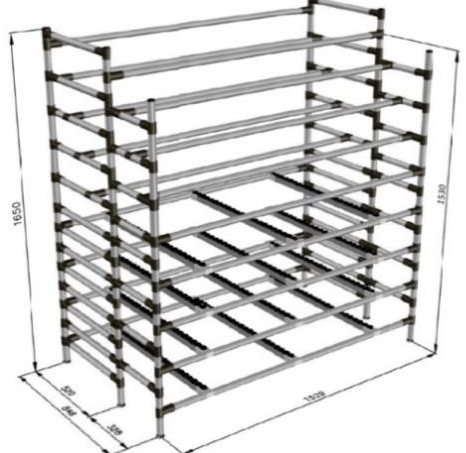
Figure 5. Design of the shelves to serve as supermarkets at the workstations.